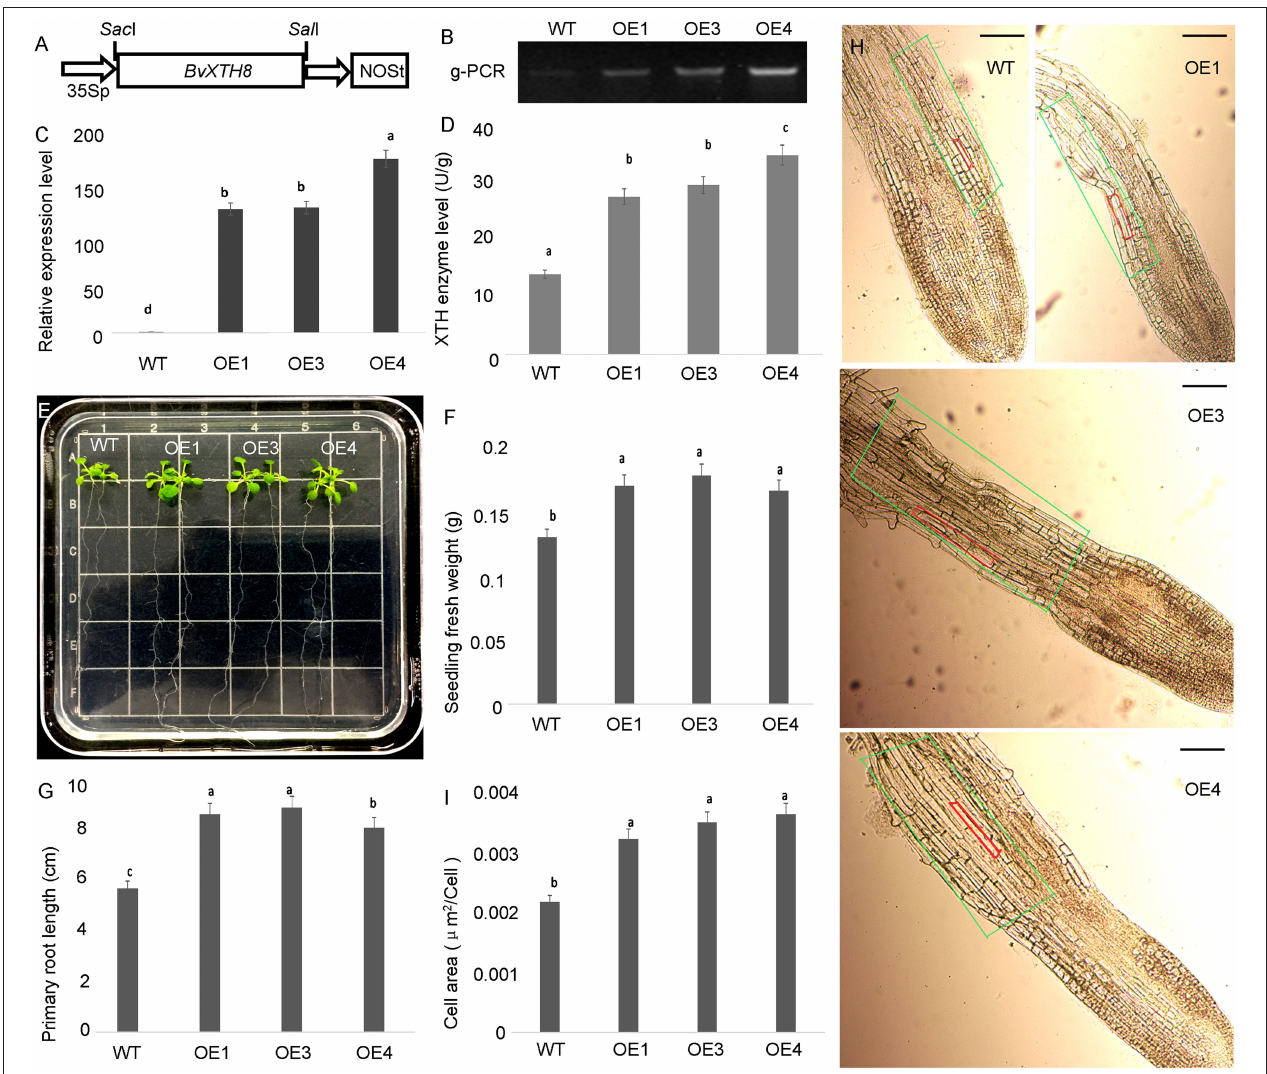
FIGURE 8 | Functional identification of xyloglucan endotransglucosylase/hydrolase 8 ( BvXTH8 ) from Beta vulgaris . (A) T-DNA region of the vector pCAMBIA1300-BvXTH8 used to produce transgenic plants. (B) Genomic PCR analysis to confirm insertion of BvXTH8 into the genome of the transgenic lines. (C) The relative expression levels of BvXTH8 were quantified in wild-type (WT) and transgenic plants by real-time RT-PCR. (D) BvXTH enzyme levels of WT and transgenic plants. (E) WT and transgenic plants grown on MS medium for 2 weeks, and measurements of the seedling fresh weight (F) and primary root length (G) . The microscopic observation of roots in WT and transgenic plants (H) , and the elongation zone areas of WT and transgenic plants were counted (I) . The superscript letters indicates the values which are not significantly different ( P < 0.05, Duncan’s MRT). The scale bar represents 100 µ m. Data are expressed as means ± standard errors ( n =